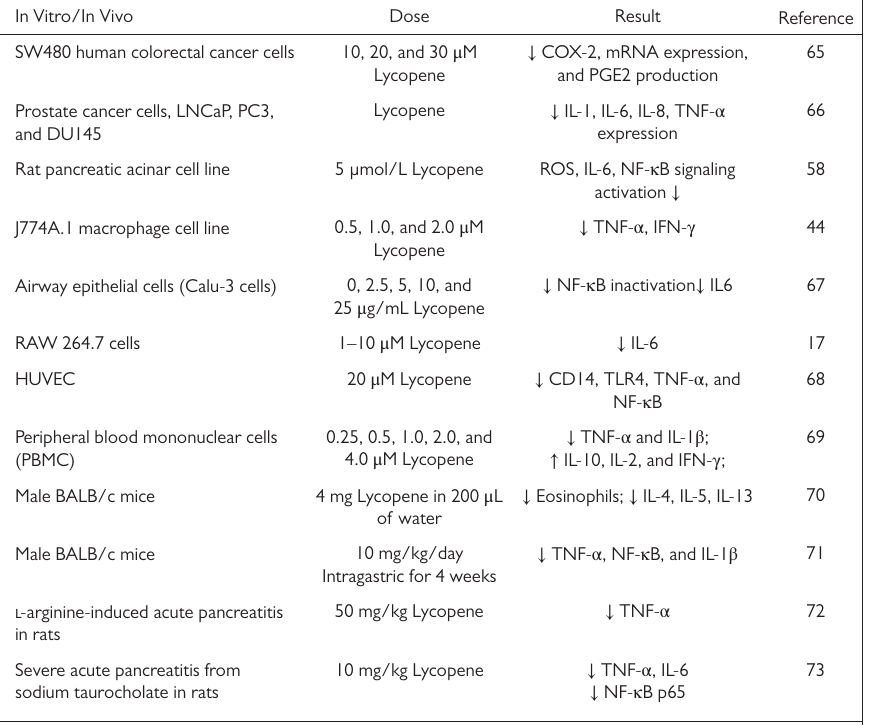
Table 1. In Vitro/In Vivo Studies About the Lycopene’s Anti-Inflammatory Properties In Vitro/In Vivo